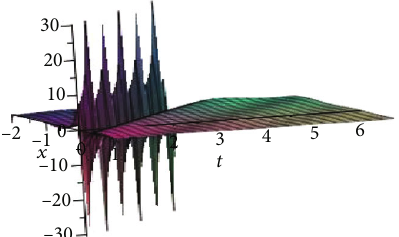
Figure 6: 3D plot of solution (30) of PDE